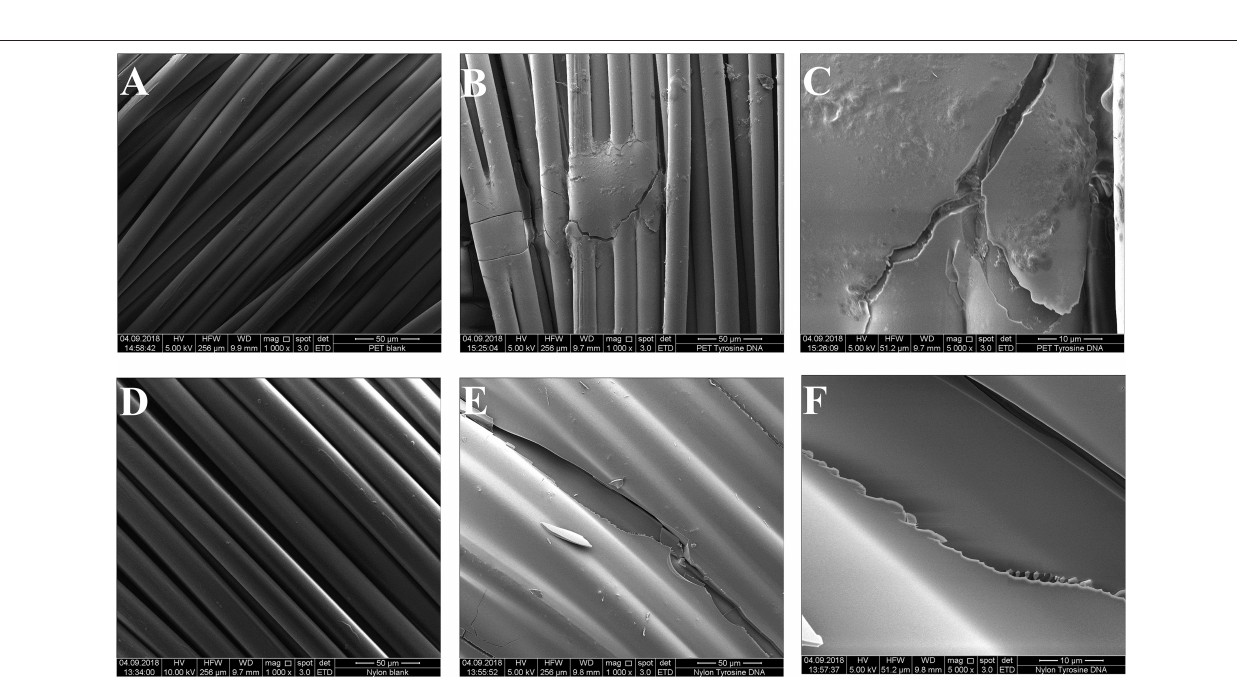
FIGURE 5 | Scanning electron microscopy images of the samples. (A) Untreated PET 1000x magnification (B) PET_tyrosine_DNA 1000x magnification (C) PET_tyrosine_DNA 5000x magnification (D) untreated nylon 1000x magnification (E) nylon_tyrosine_DNA 1000x magnification (F) nylon_tyrosine_DNA 5000x